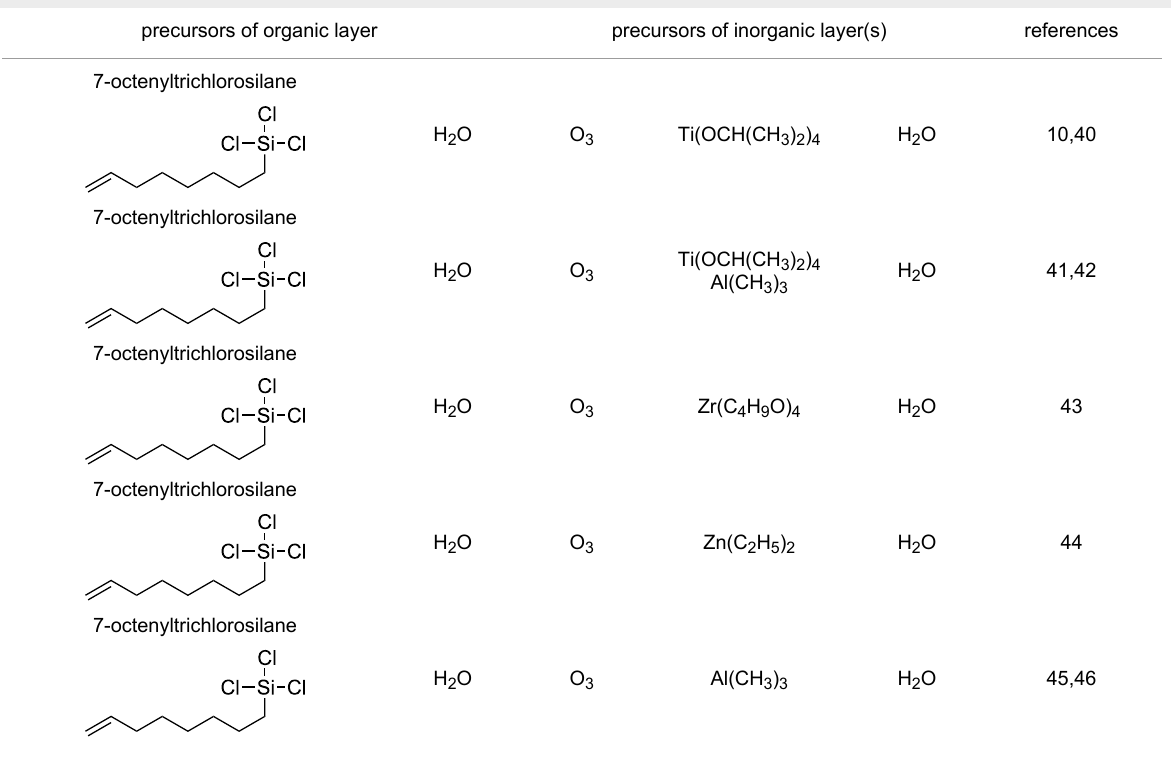
Table 15: Inorganic–organic hybrid thin film systems based on 7-octenyltrichlorosilane as a precursor. precursors of organic layer precursors of inorganic